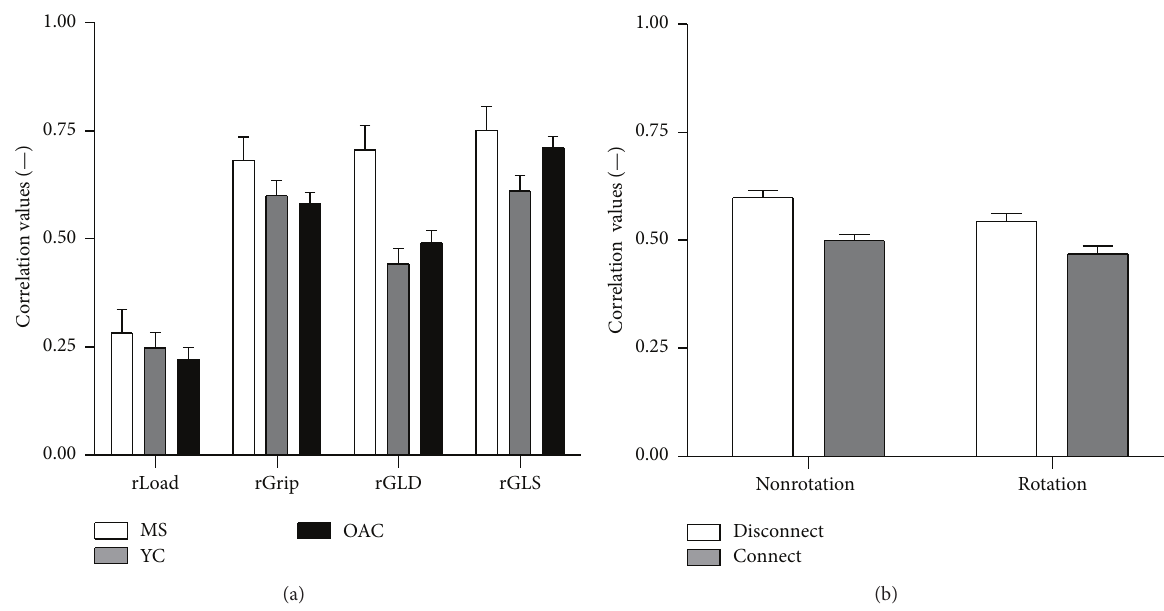
Figure 4: Mean and standard error of within-hand ( rGL participants. (a) Correlation coefficients produced by each group. (b) Correlation coefficients in each task, averaged across diagnosis